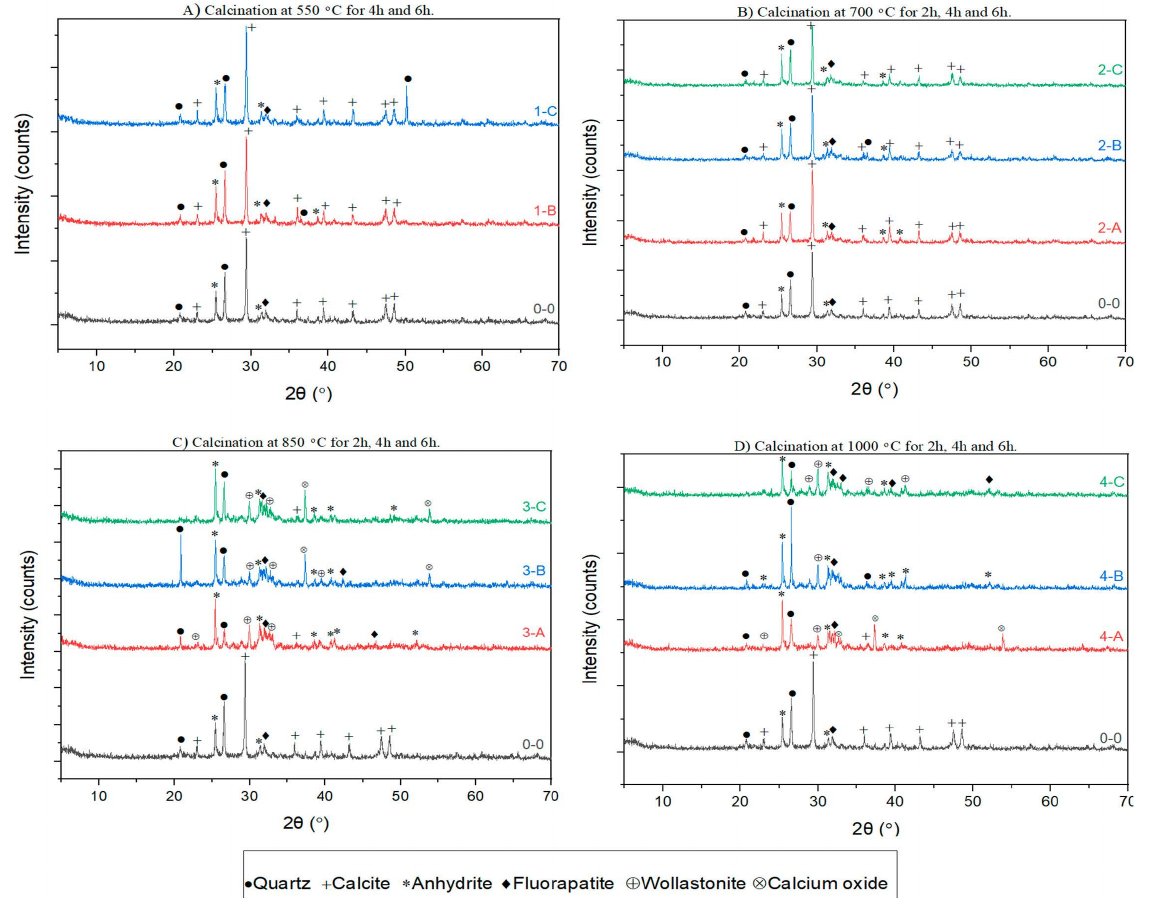
Figure 5. Comparison between XRD- patterns for ash treated at different durations for specific calcination temperatures.